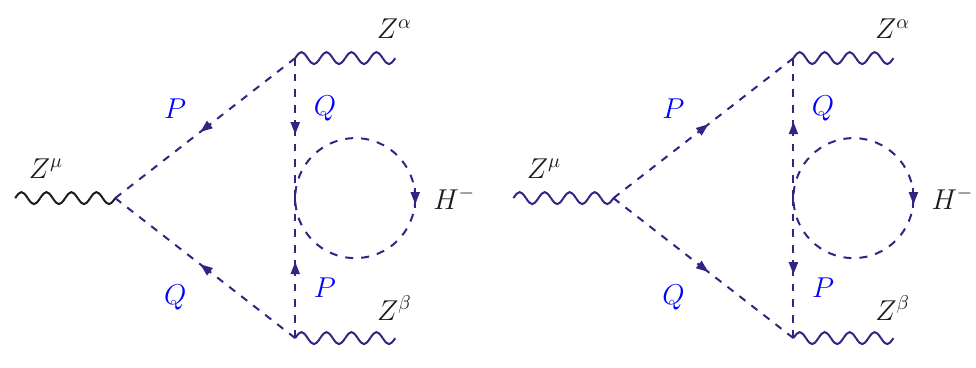
Figure 1 . A typical pair of Feynman diagrams for Z